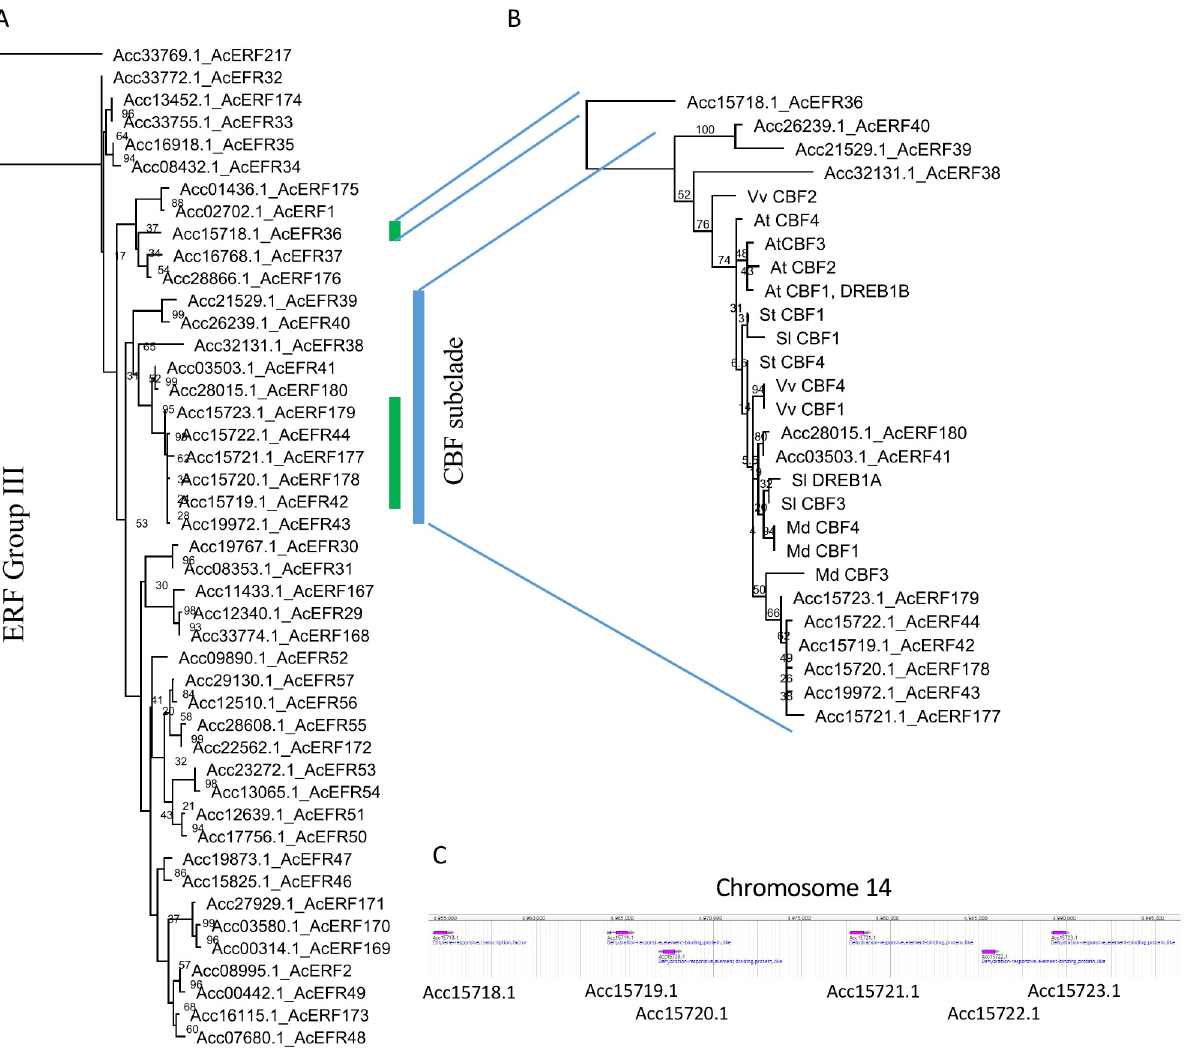
Fig 1. A . Phylogenetic alignment of the DNA binding domain of Group III ERF genes . The ancestral gene Acc33769.1 was used as an outgroup. Bootstraps of 1000 iterations given. B. A subset of Group III representing C-REPEAT/DRE BINDING FACTOR -like genes aligned to the known CBF- like predicted DNA binding domains from Arabidopsis (CBF1 AT4G25490, CBF2 AT4G25470, CBF3 AT4G25480), grape vvCBF1 (AAW58104.1) VvCBF2 (AIL00572.1), VvCBF4 (AIL00786.1), tomato SlCBF1 (Solyc03g026280.3), SlCBF3 (Solyc03g026270.3), SlDREB1A (Solyc03g124110.2) and potato StCBF1 (ABI74671.1) StCBF4 (ACB45083.1), and apple MdCBF1 (ART85558.1), MdCBF3 (ARO50175.1), MdCBF4 (ART85561.1), were used in the phylogeny, AcERF36 (Acc157718.1) as an outgroup. The blue vertical line represents the CBF-like clade, and green lines represent the Copy Number Variation event. C. Gene duplication of a CBF-like gene was identified on Chr14.